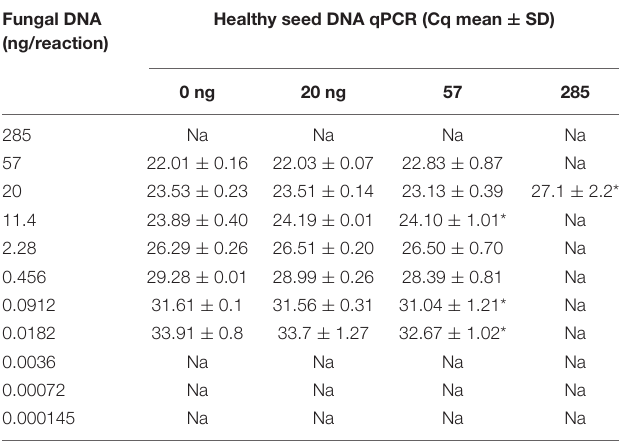
TABLE 2 | The Stagonosporopsis cucurbitacearum limits of detection estimated by qPCR method. Fungal DNA